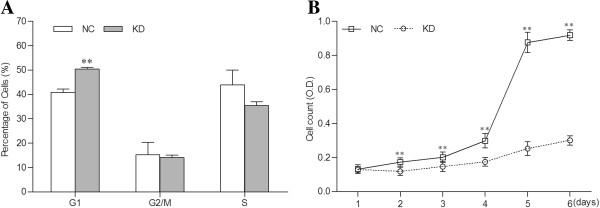
Effect of H19 knockdown on the growth of JAR cells. A, Comparison of the percentages of cells in G1, G2/M and S phase between NC and KD groups. The percentage of cells in G1 phase was significantly higher in the KD group than in the NC group, while the percentages of cells in G2/M phase and S phase respectively showed no significant changes between the two groups. B, Growth curves of cells in each group. MTT analysis showed that H19 knockdown significantly inhibited cell proliferation (n = 18). ** denotes P < 0.01.